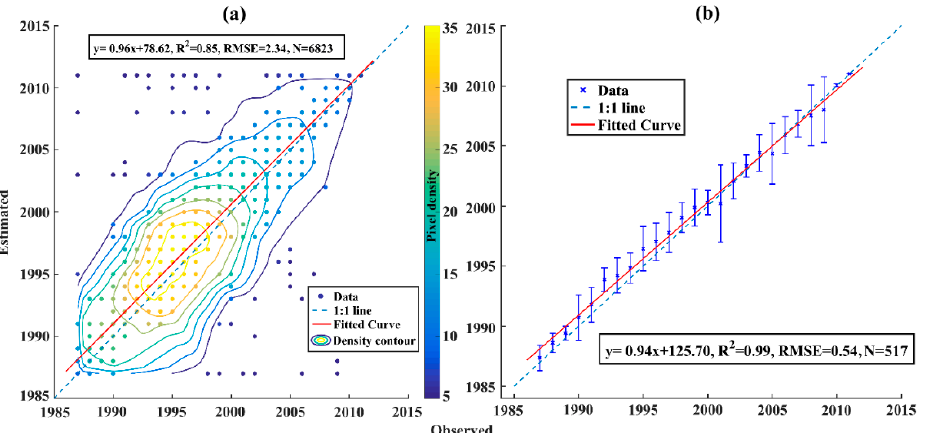
Figure 7 . Accuracy assessment of the establishment year map of rubber plantations: ( a ) scatter plot of the estimated against observed establishment year of rubber plantations at the pixel scale, and ( b ) error bar plot of mean estimated against observed establishment year of rubber plantations. Contours in ( a ) were plotted based on the number of pixels which have same observed and estimated establishment year, and error bar in ( b ) means ± 1 standard deviation.